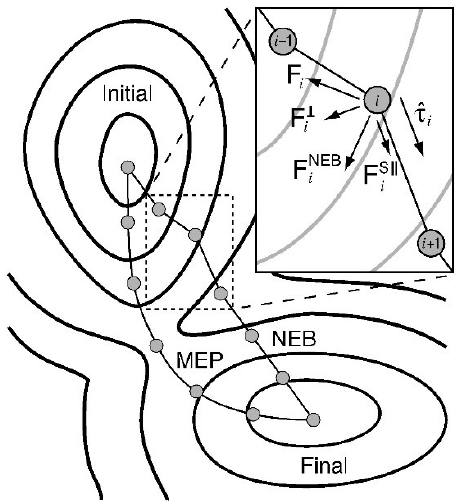
Figure 10. Illustration of the nudged elastic band (NEB) method on a potential energy surface (PES); F iNEB : nudged elastic band force, F i S || : spring force along the tangential τ i , F i ⊥ : perpendicular force, and F i : the other forces. Reprinted with permission from [26]. Copyright (2000) AIP Publishing.